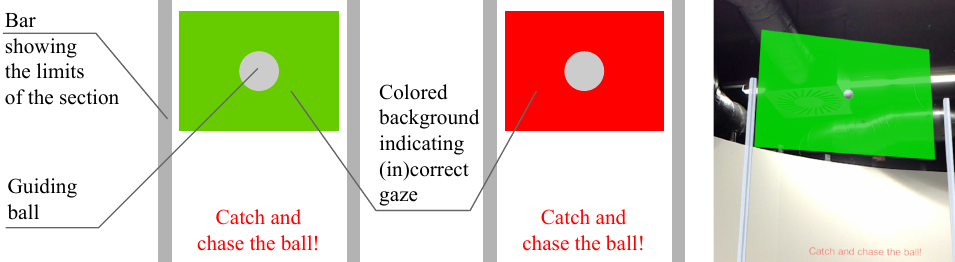
Figure 1. Augmented Reality (AR) Moving ball scheme for the scanning pattern.